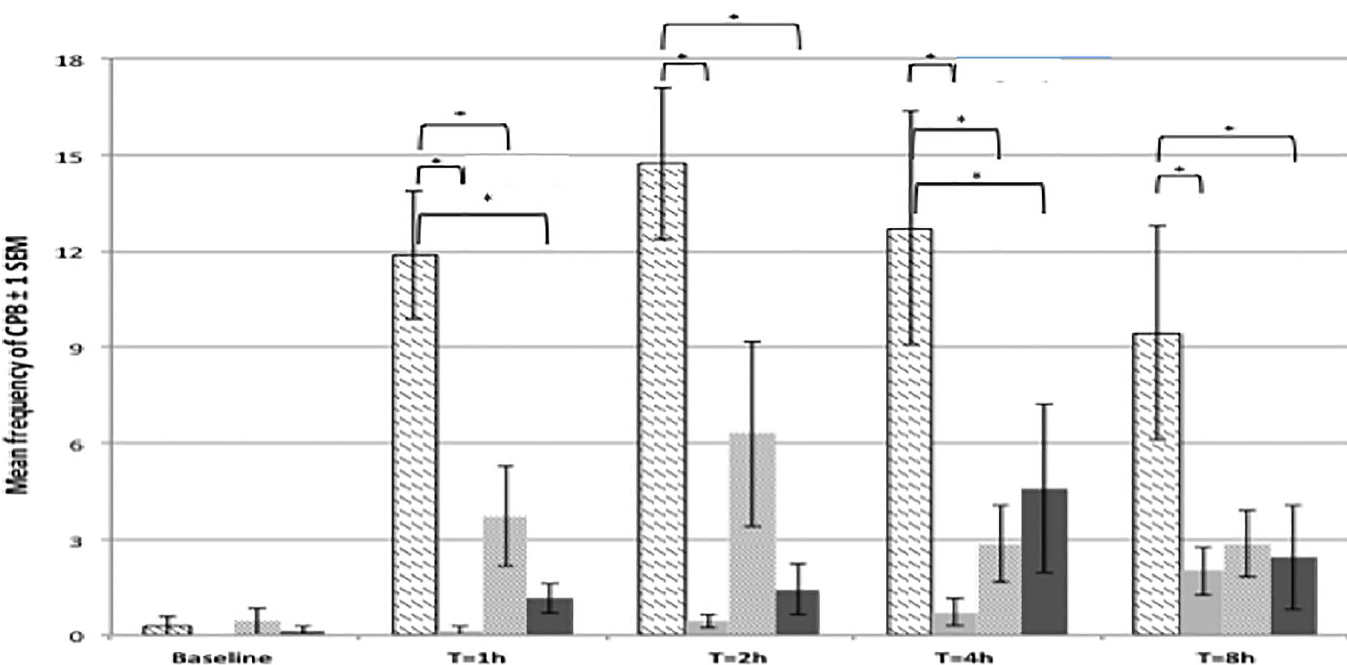
Fig 4. Mean frequencies for Composite Pain Behaviour (CPB) scores across treatments and time points. Data presented ± 2 standard error of the mean. N = 28. Significant differences ( * ) are explained in the text and Table